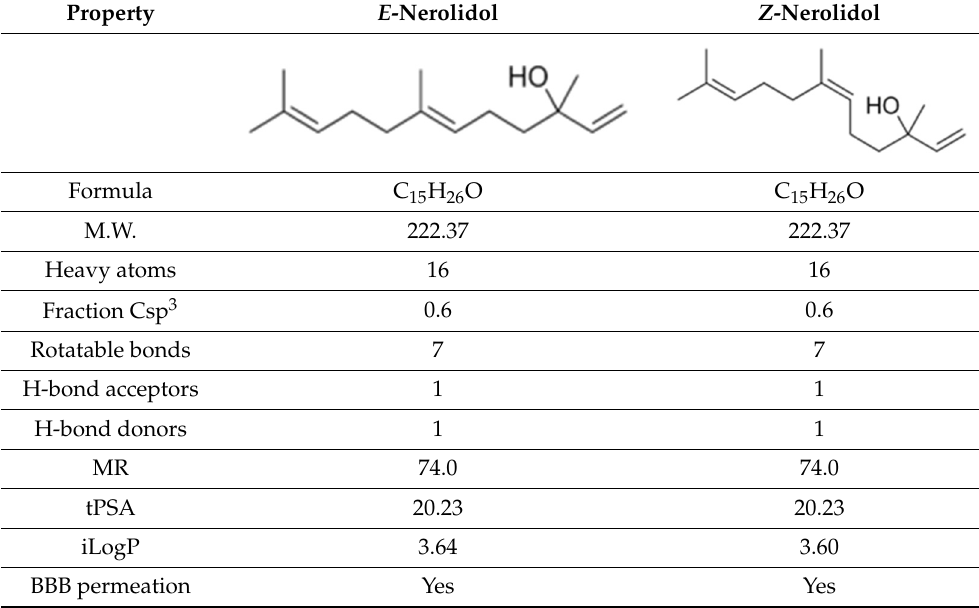
Table 3. Chemical structures and physicochemical properties of nerolidol isomers according to SwissADME results.